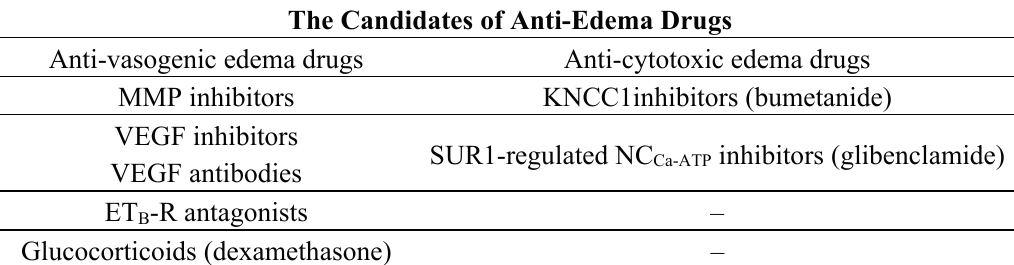
Table 1. Summary of candidate drugs for vasogenic and cytotoxic